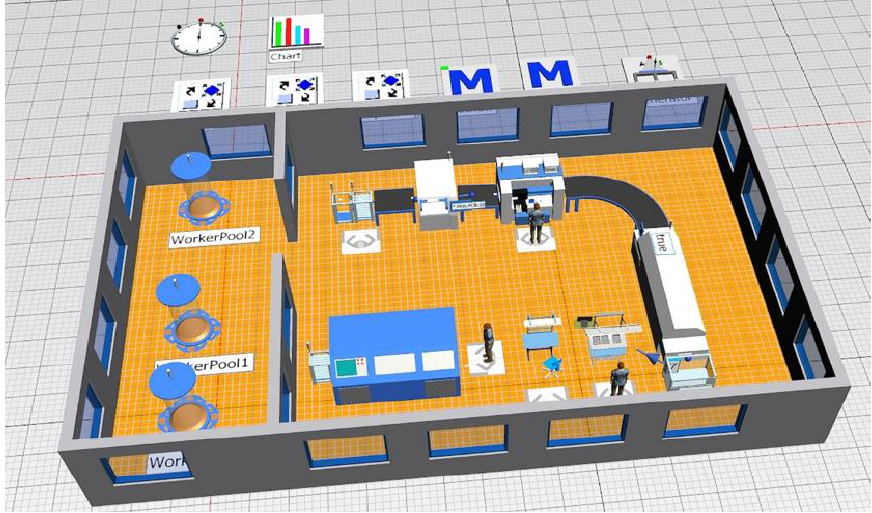
Fig. 7. The final simulation model of the assembly area using walls and floor